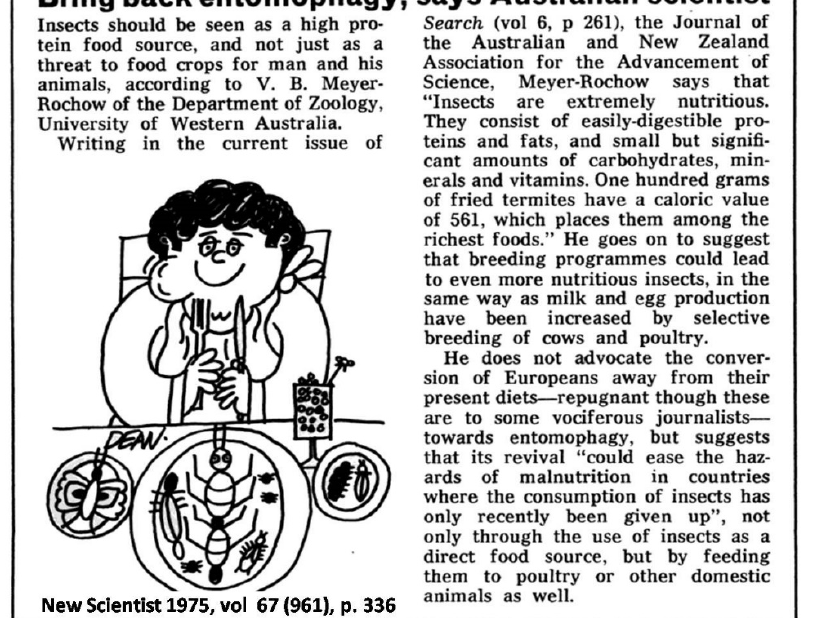
Figure 1. One of many cartoons that appeared in newspapers and magazines [6] after it had been suggested in 1975 that insects could ease the problem of global food